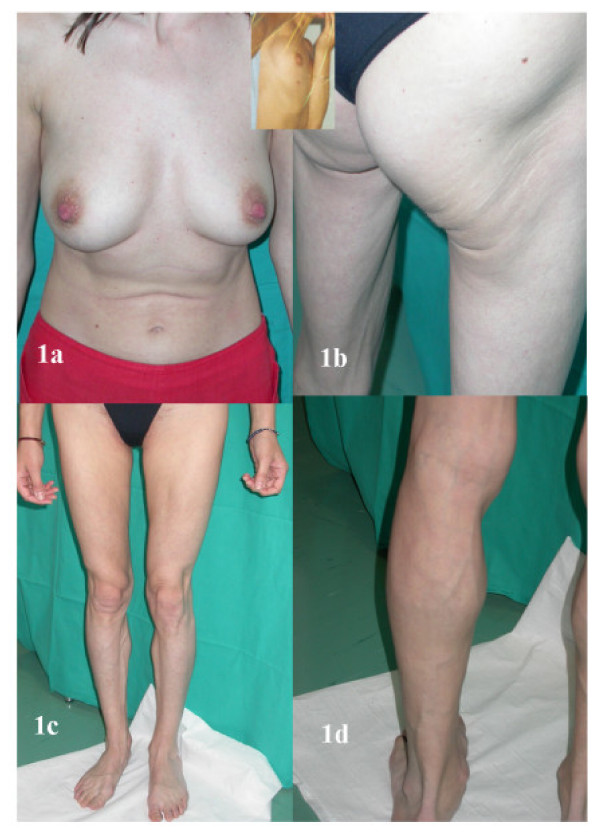
Patient's body habit details at the end of treatment interruption. 1a. Appearance of breasts. Insert. Appearance of patient's breasts before HAART. 1b. Persistent and marked lipoatrophy at buttocks. 1c. Lipoatrophy at legs, front view. 1d. Lipoatrophy of left calf, back view